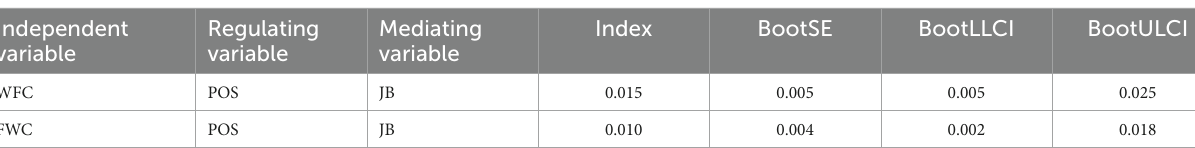
TABLE 5 Moderated mediating